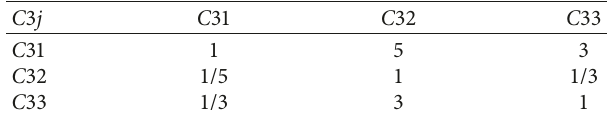
Table 7: Judgment matrix of C 3 j .